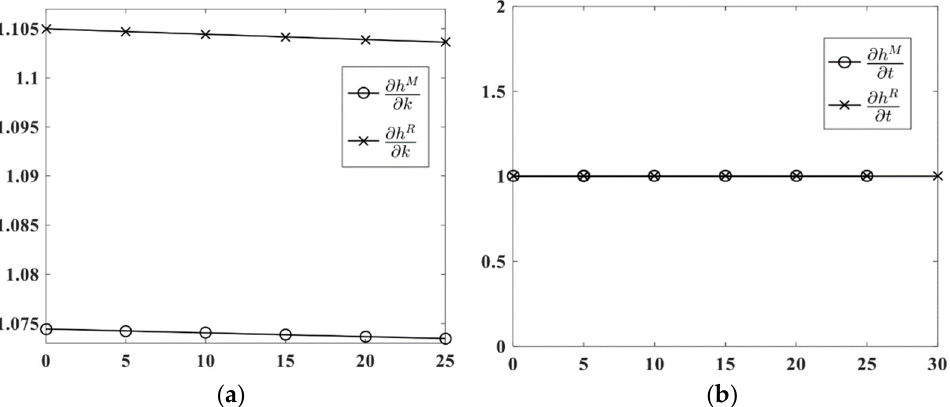
Figure 7. The impacts of 𝑡 and 𝑘 on LCT, they should be listed as: ( a ) The impact of 𝑘 on LCT; ( b ) The impact of 𝑡 on LCT.